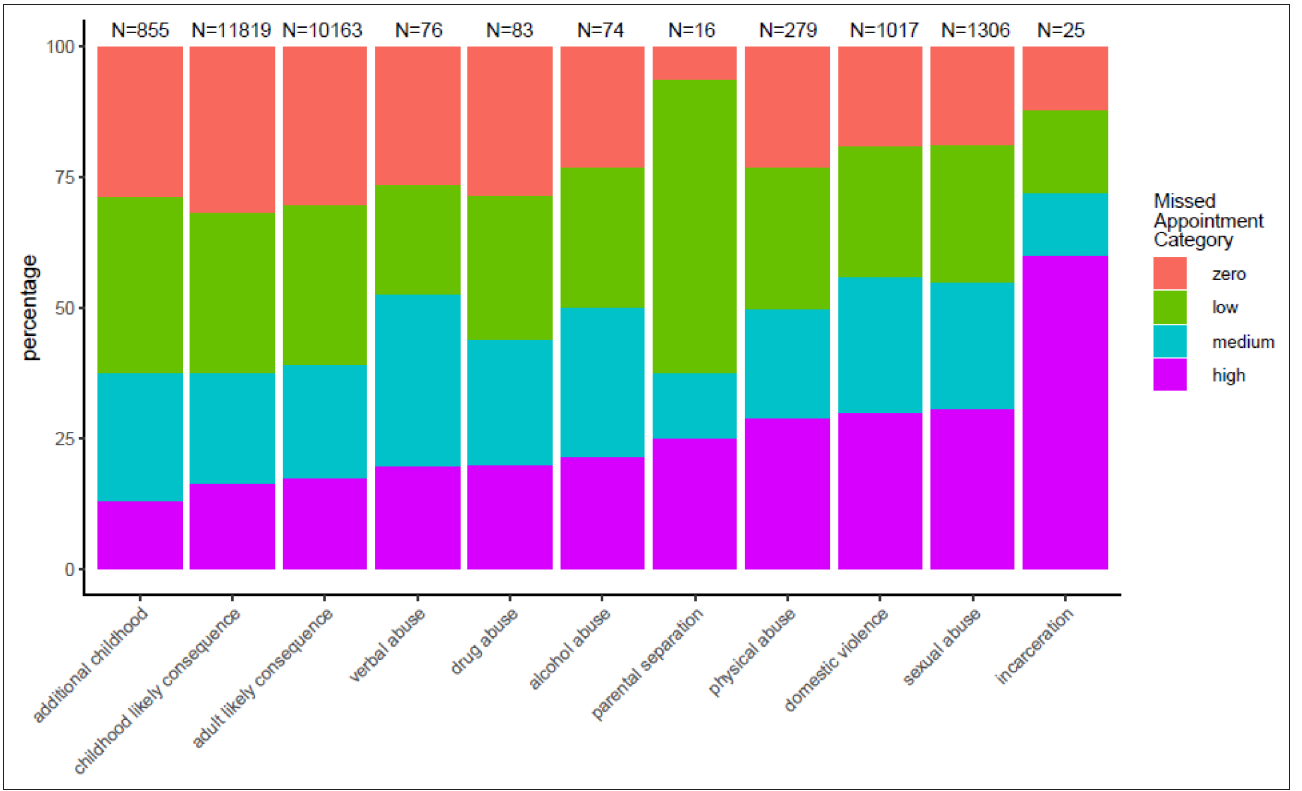
Figure 2 ACE domain by missed appointment